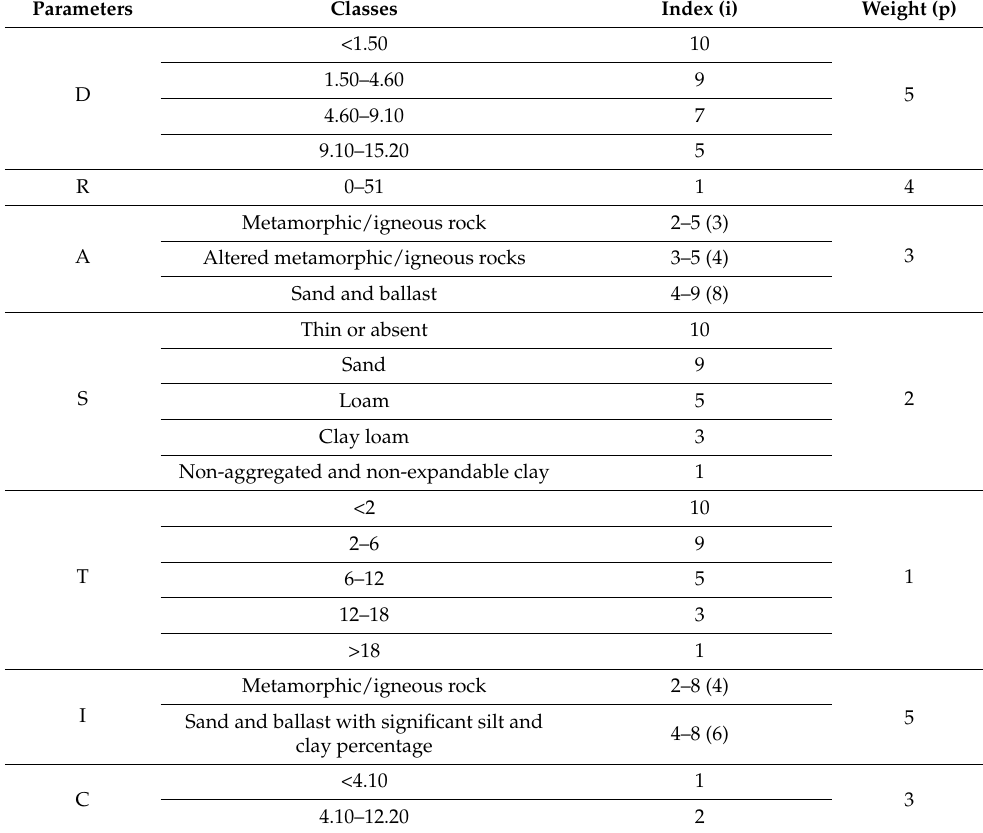
Table 2. The weight (p) and index (i) assigned to each of seven parameters used in the DRASTIC vulnerability index modelling of the area surrounding the ‘Barbeitos’ borehole (adapted from [40]).